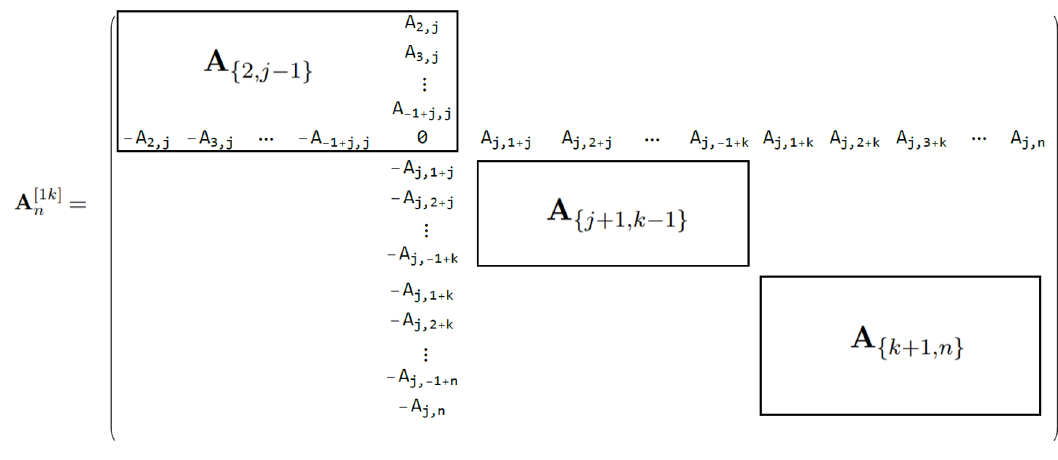
where we emphasize the three different blocks that n